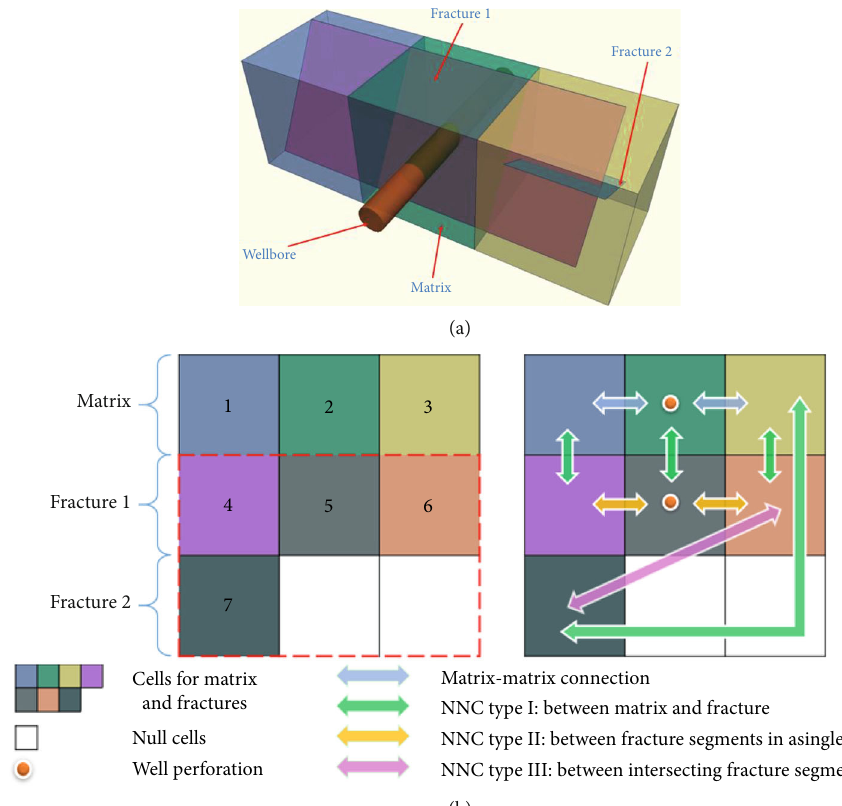
Figure 2: Explanation of embedded discrete fracture model (EDFM): (a) a physical domain with three matrix blocks, two fractures, and a wellbore, and (b) a computational domain shows the connections within each discretized cell. The arrows show the di ff erent types of nonneighboring connections (NNCs) [11].